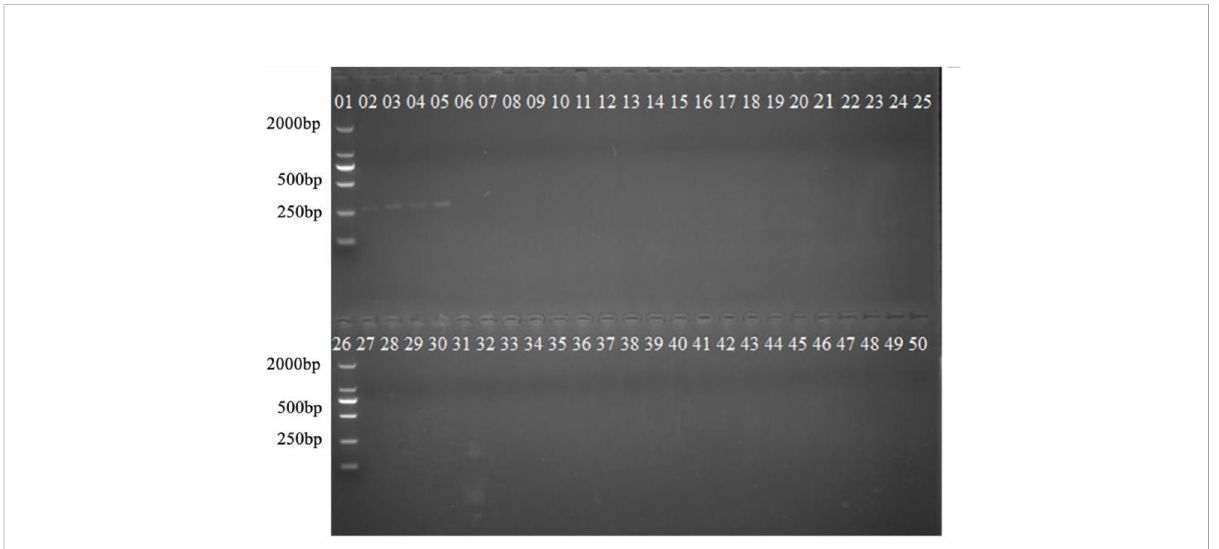
FIGURE 3 Speci fi city of the SCAR marker on T. caries . Lane 1: DL2000 DNA ladder; lanes 2 – 5: T. caries; lanes 6 – 9: T. controversa ; lanes 14 – 17: Ustilago maydis ; lanes 18 – 21: Ustilago tritici ; lanes 22 – 25: Ustilago hordei ; lane 26: DL2000 DNA ladder; lanes 27 – 30: Puccinia striiformis f. sp. tritici; lanes 31 – 34: Puccinia triticina ; lanes 35 – 38: Puccinia graminis f. sp. tritici ; lanes 39 – 42: Blumeria graminis ; lanes 43 – 46: Fusarium graminearum ; and lanes 47 – 50: ddH 2 O.